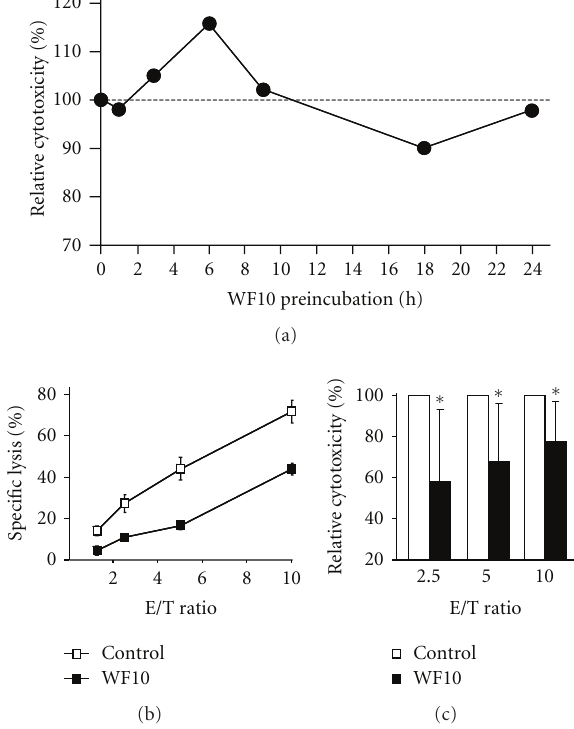
Figure 3: Time-dependent modulation of NK cell responses by WF10. (a) Freshly isolated resting human NK cells or were preincubated for the indicated times with 200 μ M WF10 and then used in a standard 4h 51 Cr-release assays against LCL721.221 target cells. Cytotoxic activity was normalized to the untreated control (set as 100%). Shown are the average values of two independent experiments using NK cells from di ff erent donors. (b, c) Freshly isolated resting human NK cells were incubated with or without 200 μ M WF10 in culture medium for 18h. Cells were then resuspended in fresh medium and tested as described above. Panel (b) showsthe results of a representative experiment. In panel (c) the activity of the WF10-treated cells is shown relative to the cytotoxic activity of control cells (set as 100%) as an average value from 8 independent experiments. The ratio of each outcome and its control was tested against a value of 1 (equality) by two-sided single-sample t -tests ( ∗ P < . 05).